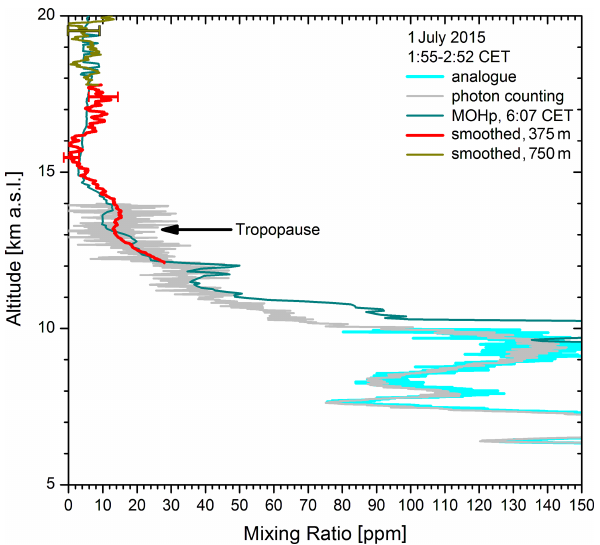
Figure 11. Water-vapour mixing ratio obtained for the measurement in Fig. 11; the calibration is based on looking at zones of best agree- ment below 7km between the sonde data for Munich (01:00CET), Innsbruck (04:00CET) and Hohenpeißenberg (06:00CET). Just the Hohenpeißenberg (MOHp) results are displayed here because they agree best with the lidar values above 11km. 51 and 101pt arithmetic-means smoothing was applied to the mixing ratios de- rived from the photon-counting data at high altitudes; the corre- sponding VDI vertical resolutions are specified in the legend.